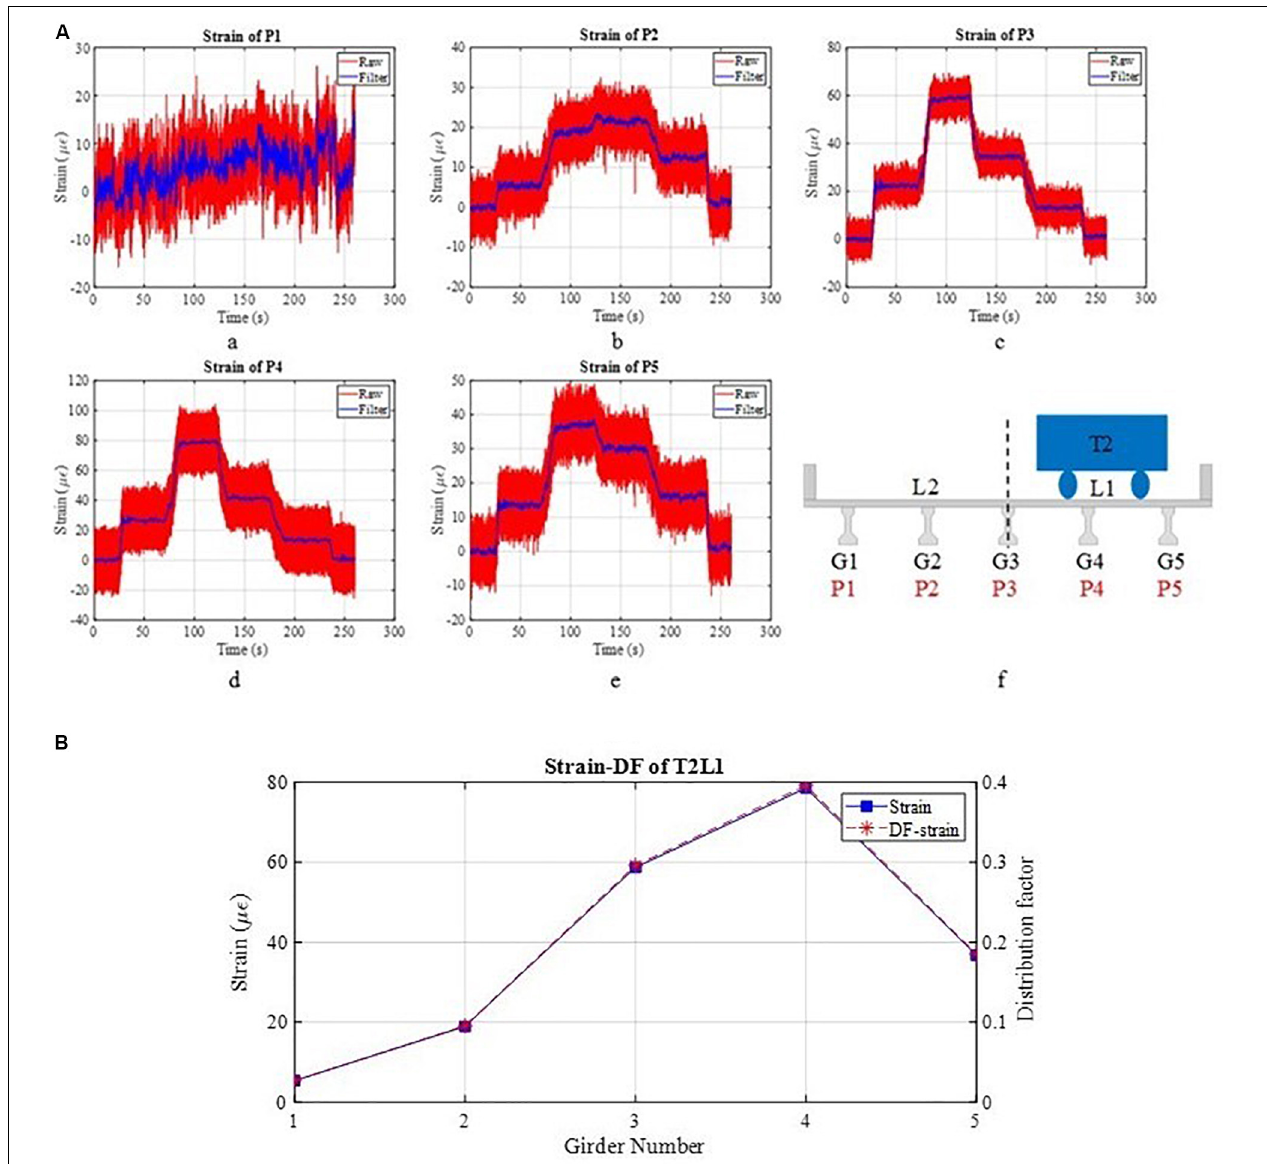
FIGURE 7 | (A) Strain results of static load case T2L1 (B) Distribution factor calculated from strain results.